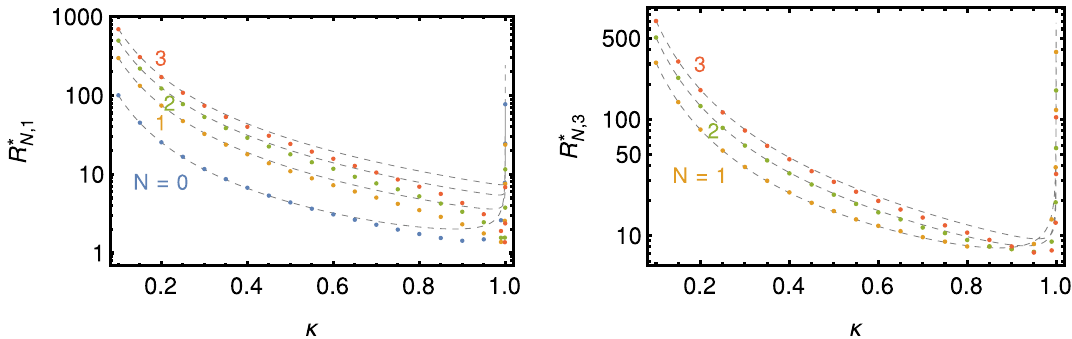
Fig. 5 Transition radii R ∗